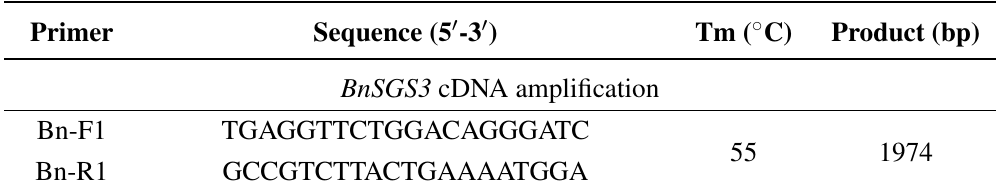
Table 1. List of